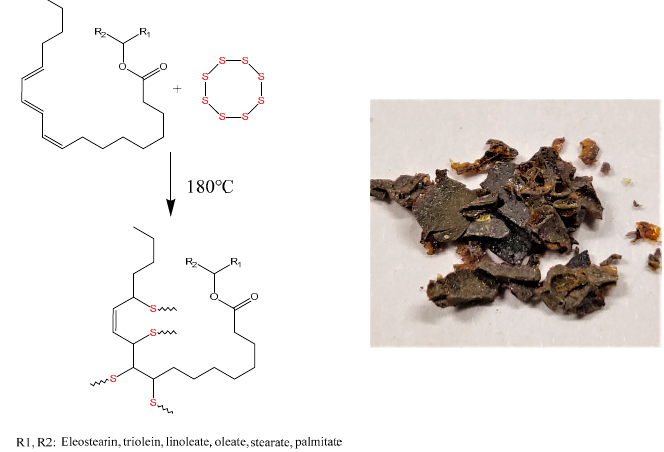
Figure 2. The reaction formula of poly (sulfur-tung oil) (poly(S-T)) copolymer and the product photograph.